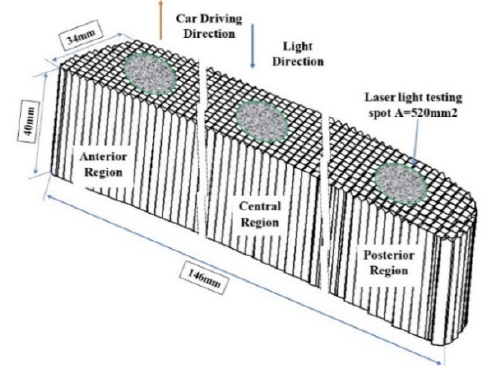
Figure 11. The areas for testing of SuperPin Plus curve (each area is 520 mm 2 ).